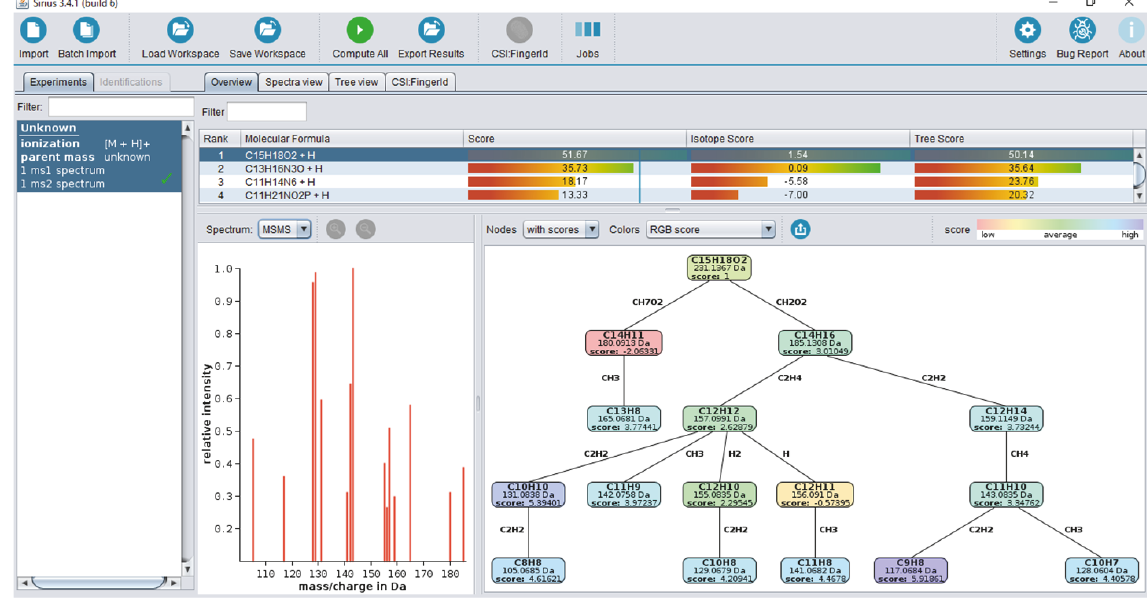
Figure 4: SIRIUS screenshot showing results obtained for the precursor ion m/z 231.1367; experimental MS/MS spectrum, fragmentation tree, and the first molecular formulas with respective score values are